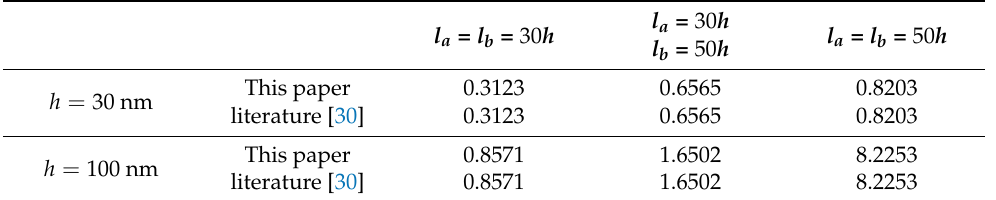
Table 1. Comparison of deflection values at the centers of the plates.